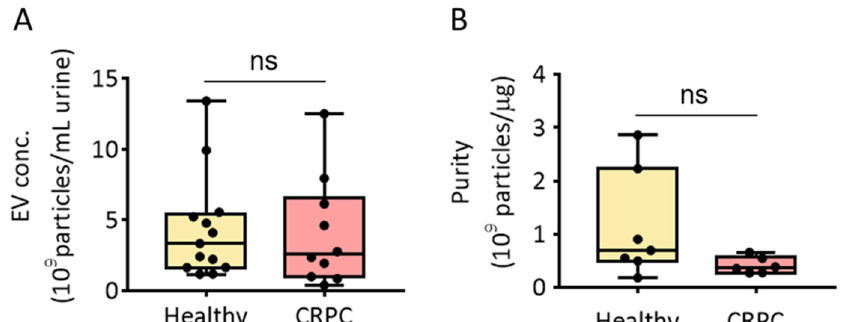
Figure 2. Isolation of urinary EVs via PEG precipitation from healthy donors and patients with CRPC. ( A ) Urinary EV concentration (EV particles/mL urine) from healthy donors and patients with CRPC. ( B ) Urinary EV purity (EV particles/µg protein) from healthy donors and patients with CRPC. All values are presented as the median ± SD (ns: no significance; n = 6–13).